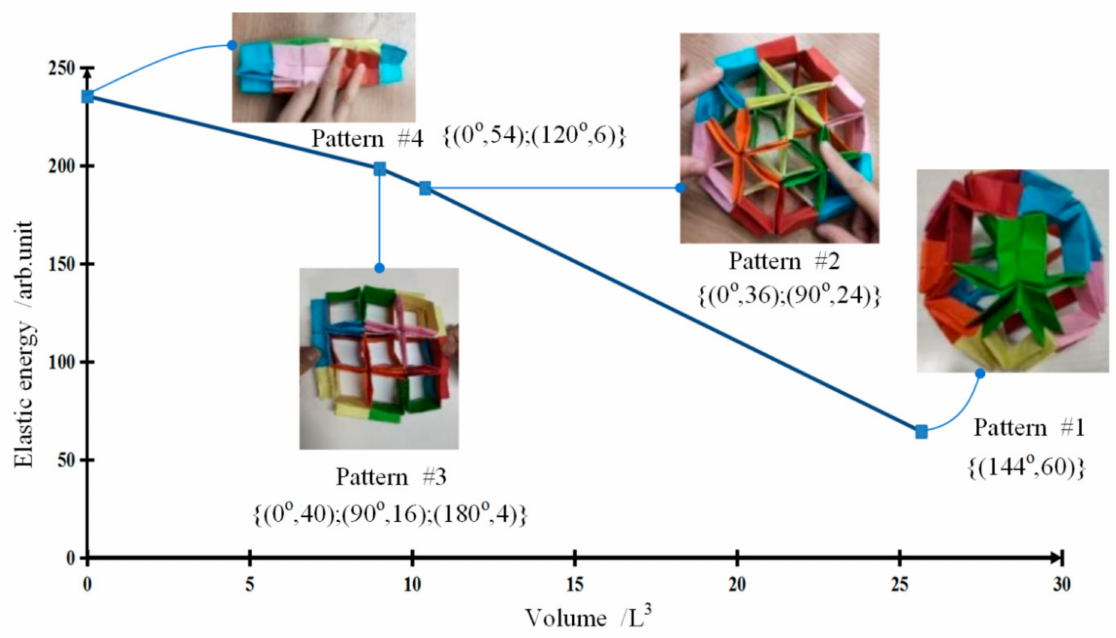
Figure 4. Shape shifting, energy landscape and cavity volume of rhombic triacontahedron